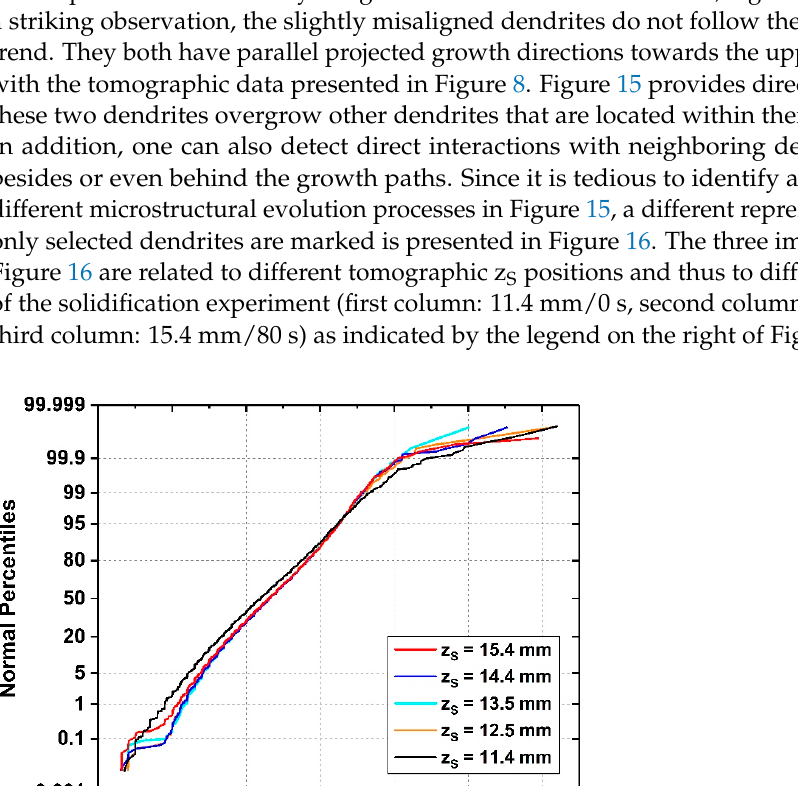
Figure 16. Specific aspects of interactions between dendrites, isolated from the image series in Fig- ure 15. ( a ) Overgrowth of matrix dendrites by slightly misaligned dendrites. ( b ) Branching events and formation of tertiary dendrites behind the growth path of misaligned dendrites. ( c ) Early stages of branching of dendrites located close to the growth paths of misaligned dendrites. For details, see text.